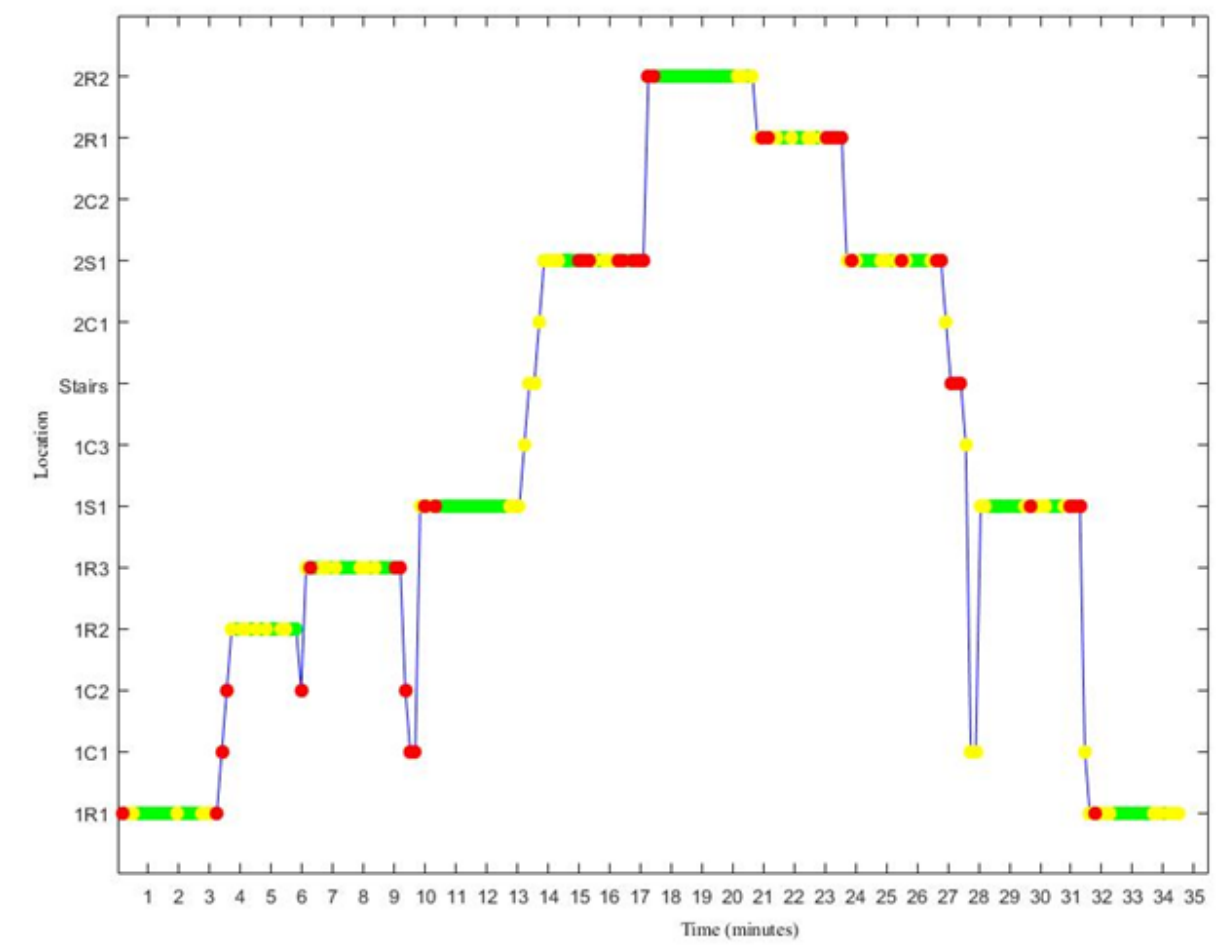
Figure 8. The combination of localization tracking and activity data of trial 1. The green, yellow, and red color indicate low, middle, and high level of activity,